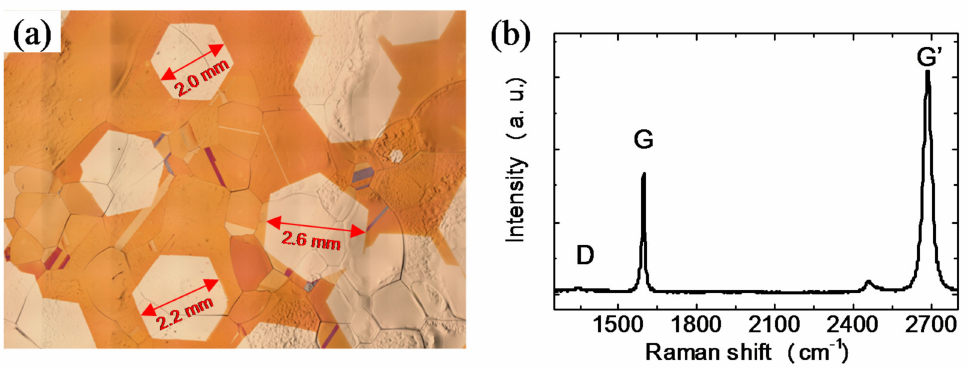
Figure 7. ( a ) Optical microscope image of large-sized single-crystal graphene. The graphene was grown by a CVD with the H 2 /Ar and the Ar annealing for 100 and 35 min, respectively; ( b ) Raman spectrum of a millimeter scale CVD graphene transferred on a SiO 2 /Si substrate.